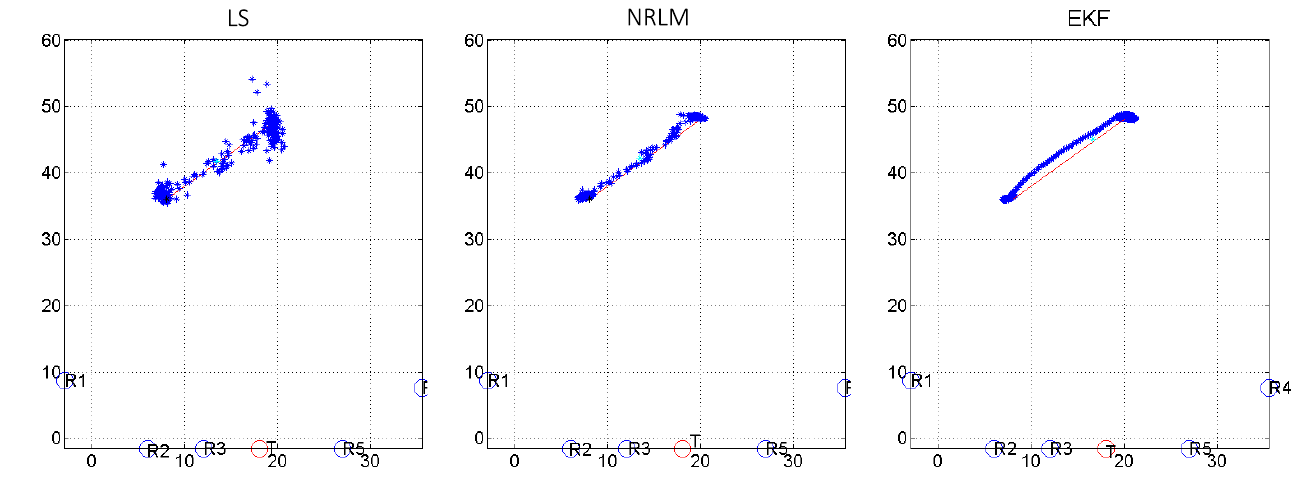
√ 2 cm/s. (Blue dots: the